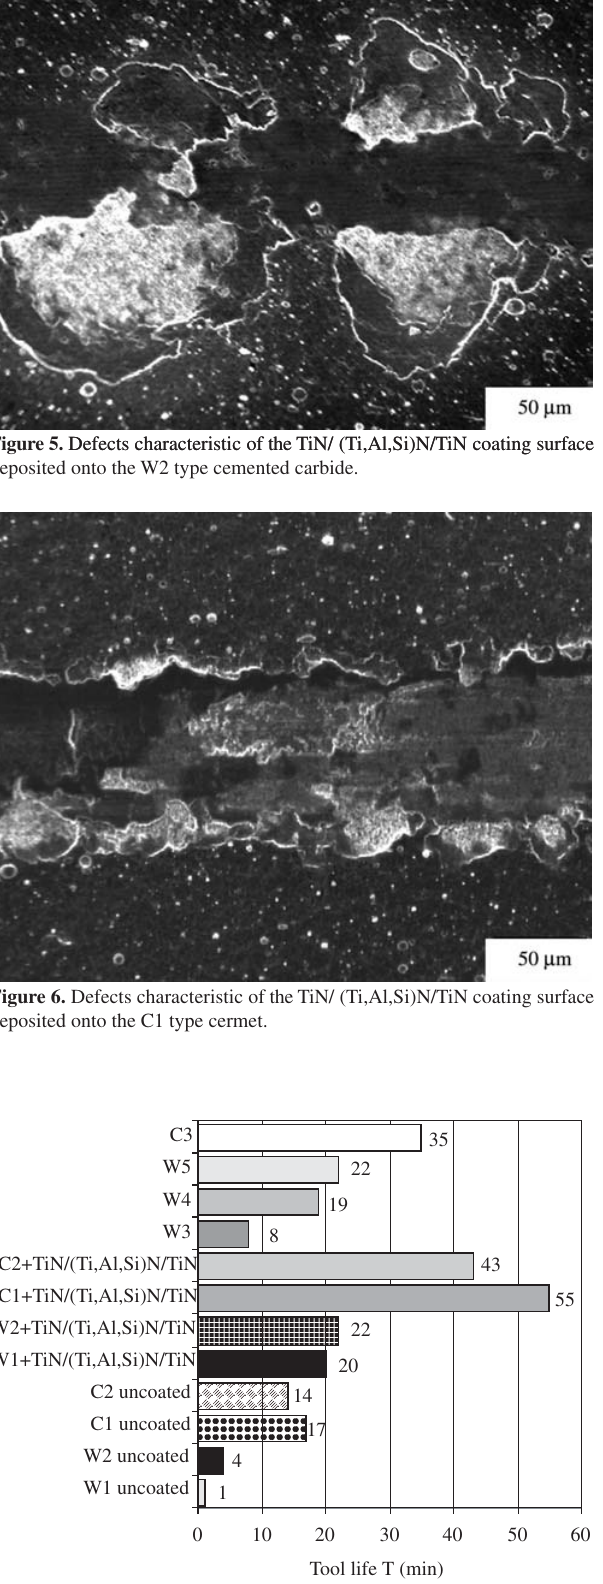
Figure 7. Comparison of tool life of tools made from cemented carbides and cermets with the TiN/ (Ti,Al,Si)N/TiN type coatings with commercially available